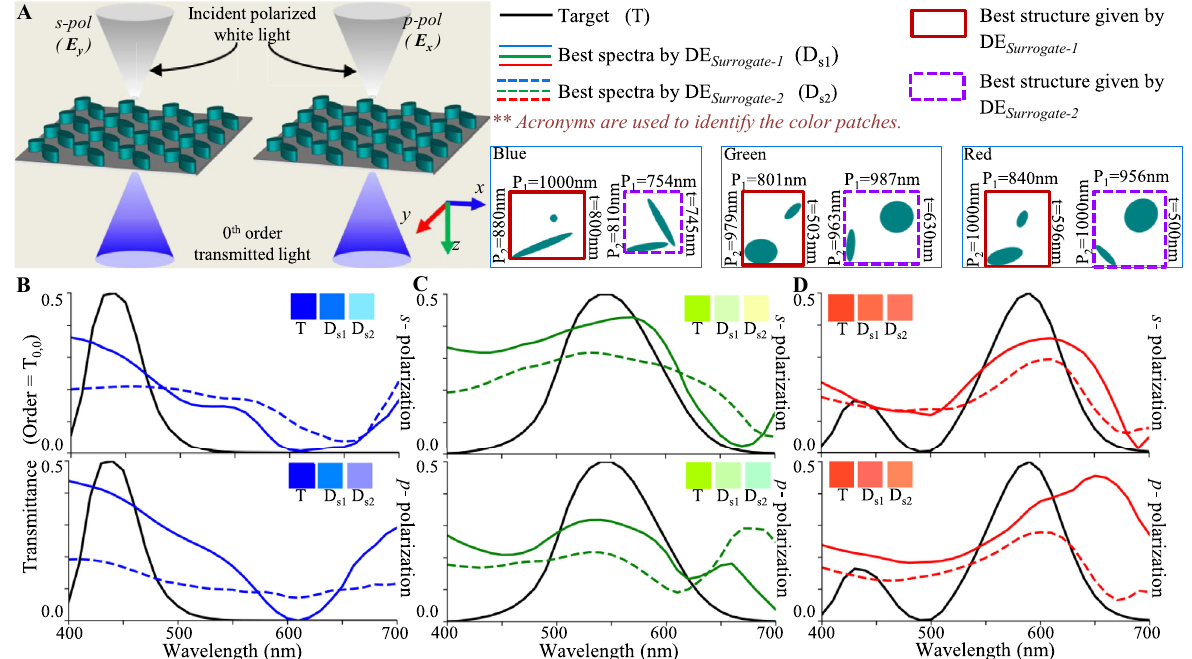
and DE . Surrogate-1 Surrogate-2 and Surrogate-1